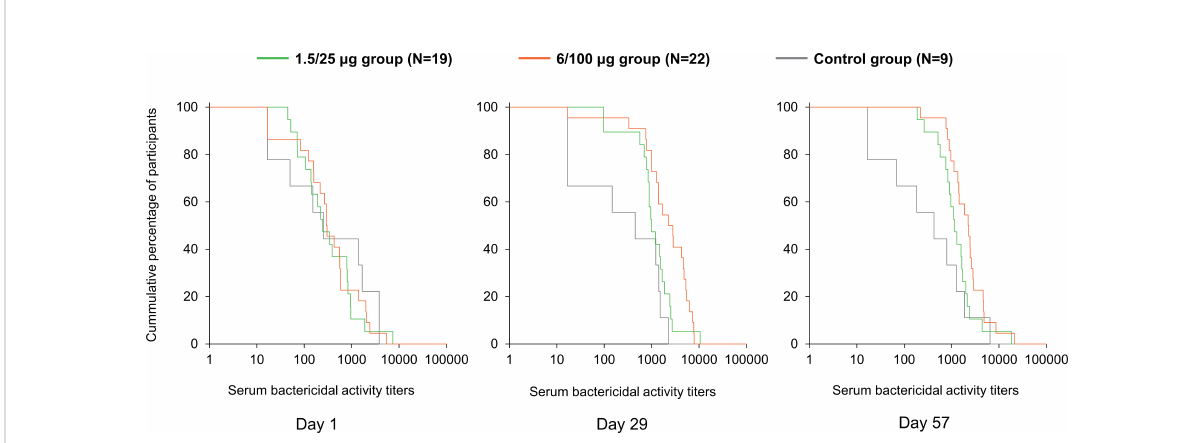
FIGURE 3 Reverse cumulative distribution curves for SBA titers (full analysis set). Day 1, pre-vaccination; Day 29, 28 days post- fi rst vaccination; Day 57, 28 days post-second vaccination; 1.5/25 µg group, participants receiving the 1.5/25 µg O antigen/protein vaccine formulation; 6/100 µg group, participants receiving the 6/100 µg O antigen/protein vaccine formulation; Control, participants receiving a quadrivalent meningococcal conjugate vaccine at Day 1 and a vaccine against tetanus, diphtheria, and acellular pertussis at Day 29.